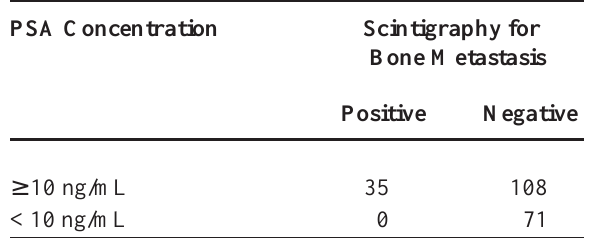
Table 1 – Relationship between prostate specific antigen (PSA) concentrations, cutting point of 10 ng/mL, and presence of bone metastasis in scintigraphy for patients with prostate cancer.